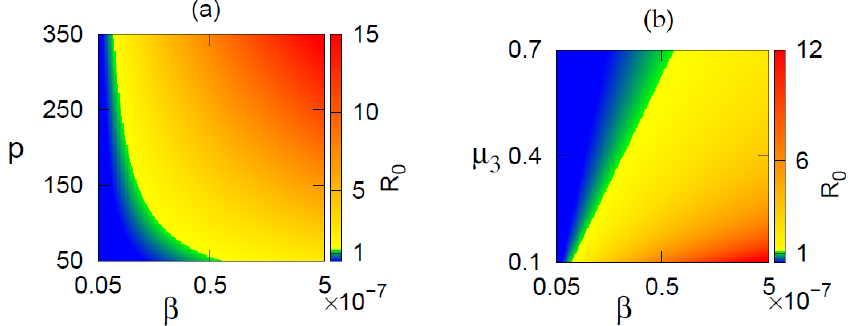
Figure 3. Region of stability of disease-free equilibrium (DFE) and endemic equilibrium (EE) shown in ( a ) β − p , ( b ) β − µ 3 parameter planes. Color represents the value of R 0 . DFE is stable for R 0 < 1 and unstable for R 0 > 1. EE exists and is stable for R 0 >